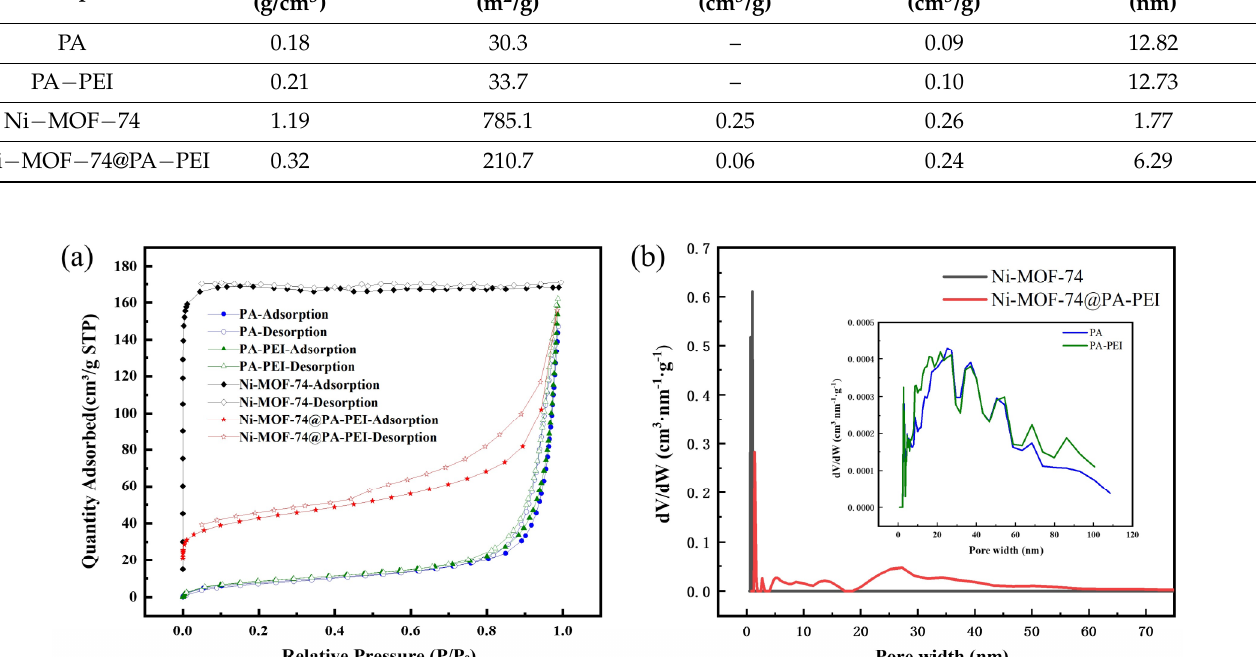
Figure 8. ( a ) N 2 adsorption/desorption isotherms and ( b ) the pore size distribution of PA, PA−PEI, Ni−MOF−74, and Ni−MOF−74@PA−PEI.